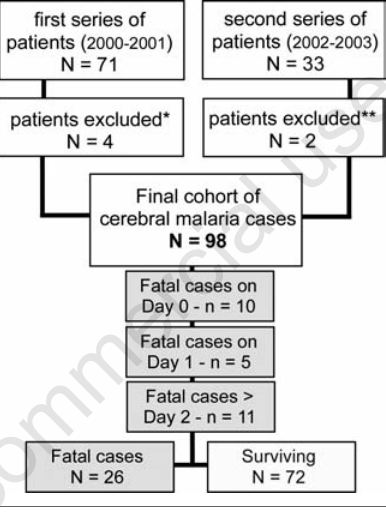
Figure 1. Summary of the recruitment for cerebral malaria patients. In this figure is summarized the sequence of recruitment of patients. 6 cases were excluded after exam- ination of patient’s files indicating a past of infection, which was also reflected by ele- vated level of PCT (mean level=196 nanog per mL). Patients excluded from the first recruitment comprised 1 fatal outcome and showed a recent history of local abscess, microbial pharyngitis and pneu- monia. Patients excluded from second recruitment were 2 fatal cases with a histo- ry of pulmonary infection by acinetobacter and pneumonia, respectively.